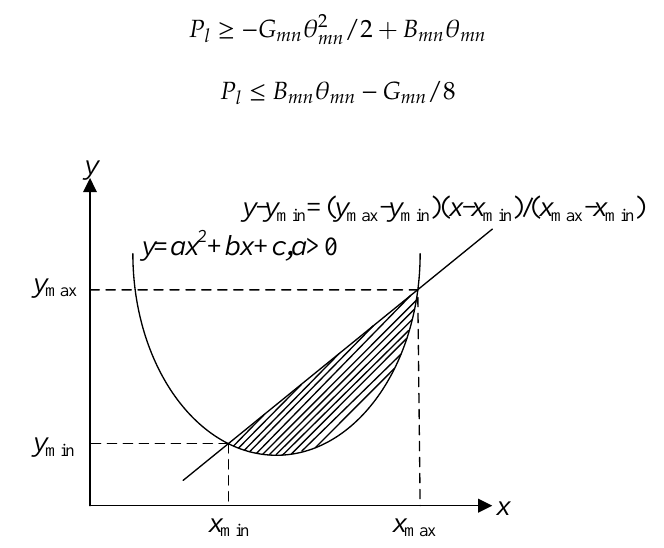
Figure 2. Convex hull of the quadratic equality.